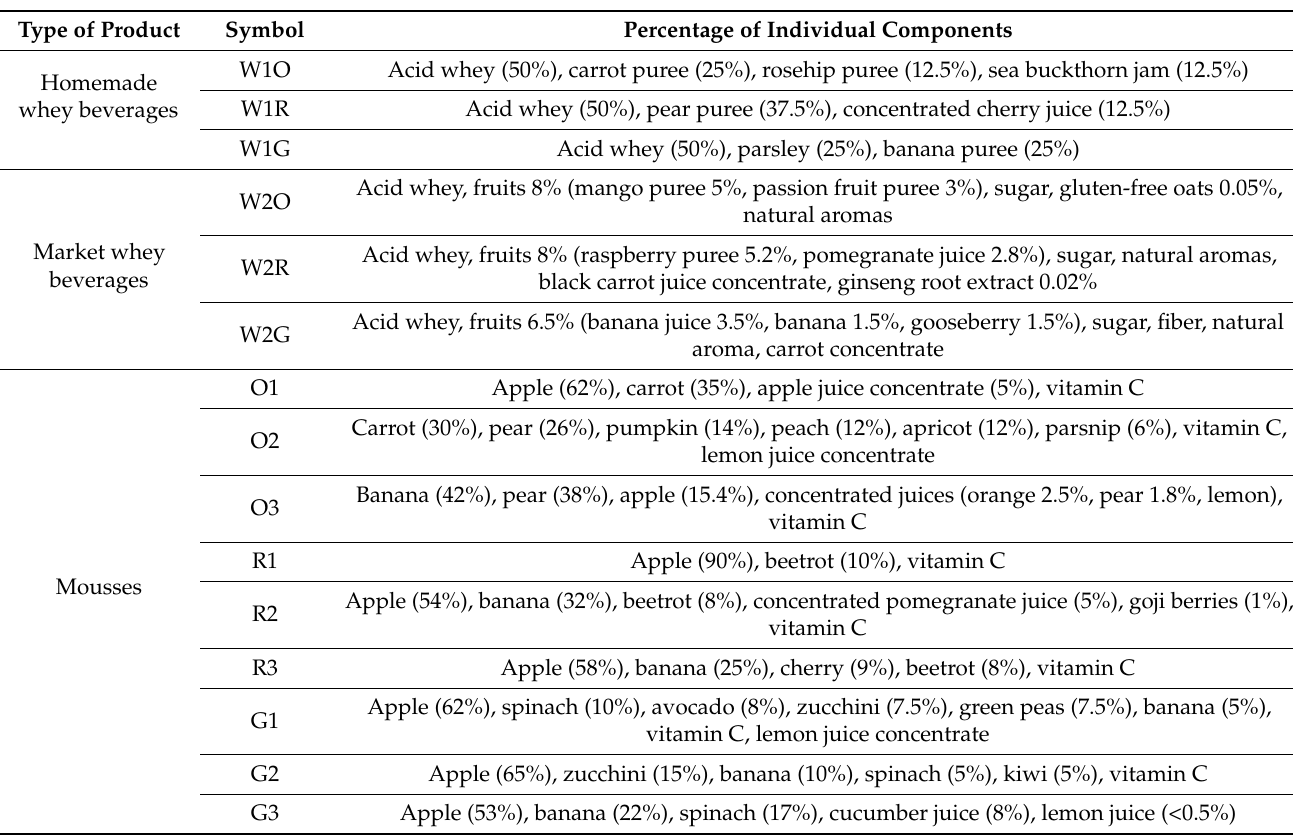
Table 3. Percentage composition of the fruit and vegetable whey beverages and fruit and vegetable mousses. Type of Product Symbol Percentage of Individual Components Homemade whey